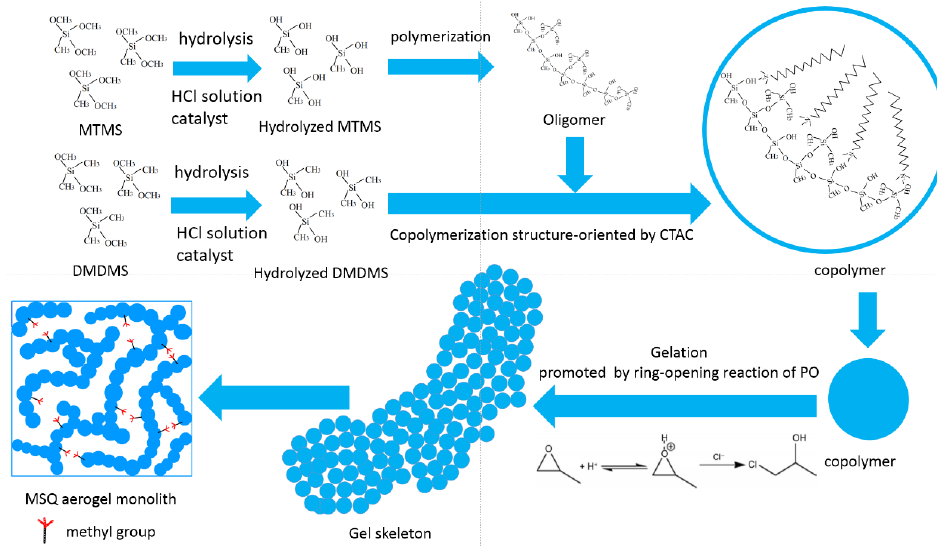
Figure 1. Reaction scheme of the sol – gel process for the MTMS – DMDMS derived MSQ aerogel.